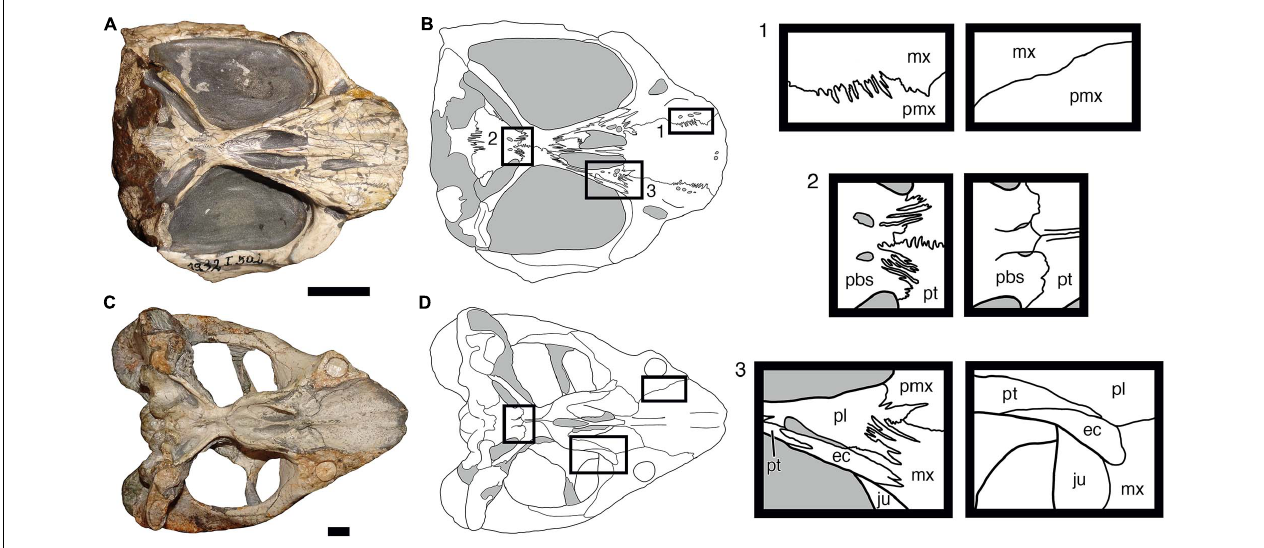
FIGURE 4 | Comparisons of sutural complexity on the ventral surface of the skull in two dicynodonts. (A,B) Photograph and interpretive drawing of Cistecephalus microrhinus (BSPG 1932-I-502). (C,D) Photograph and interpretive drawing of Dicynodon lacerticeps (SAM-PK-K7011). Boxes to the right show magnified views of select sutural boundaries from the interpretive drawings, with Cistecephalus sutures shown in the left column and Dicynodon sutures in the right. ec, ectopterygoid; ju, jugal; mx, maxilla; pbs, parabasisphenoid; pl, palatine; pmx, premaxilla; pt, pterygoid. Gray regions in interpretive drawings indicate matrix. Scale bars represent 1